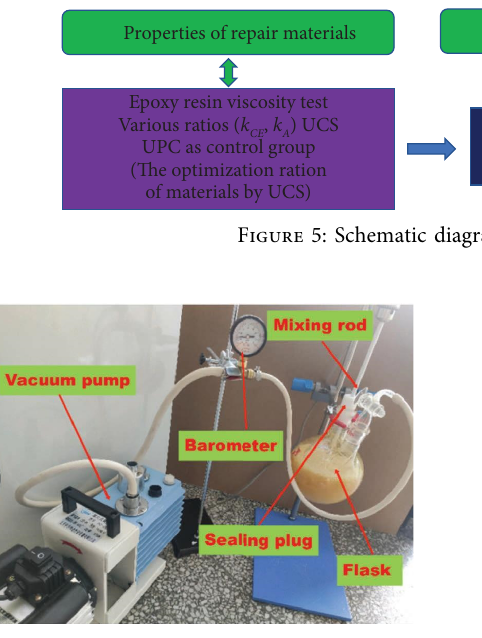
Figure 6: Epoxy resin mixed with a vacuum